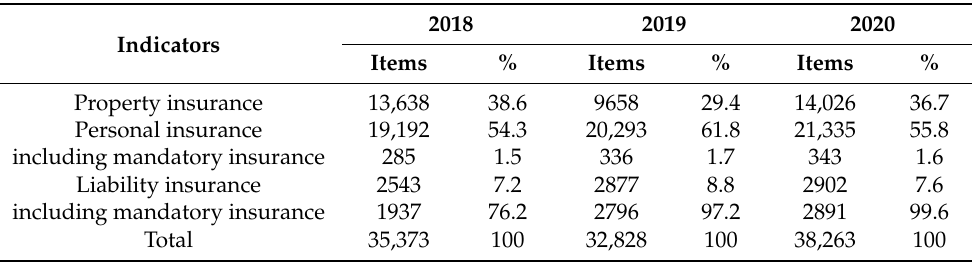
Table 2. The number of valid contracts by the type of insurance in Renaissance Insurance from